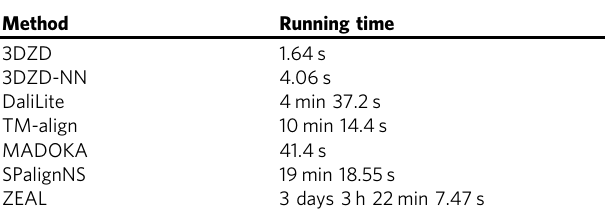
Table 2 Comparison of computational